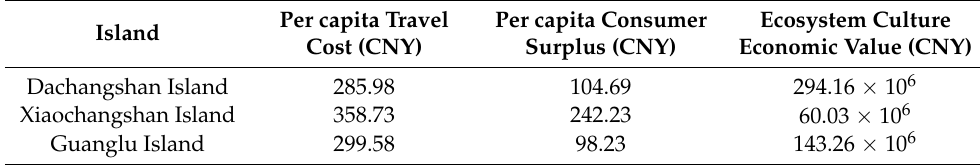
Table 7. Recreational and cultural ecosystem services value of each island in